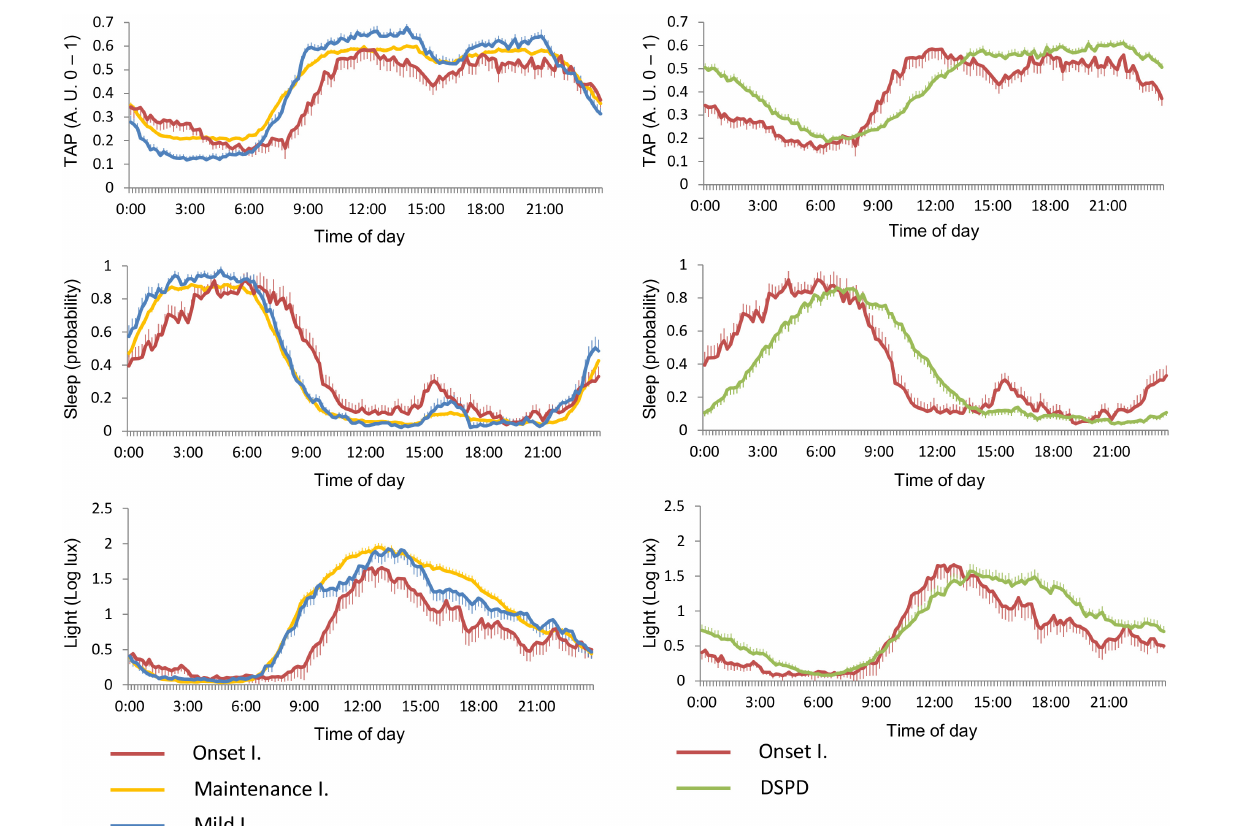
FIGURE 4 | Mean circadian waveforms (from top to bottom) for TAP, estimated sleep, and exposure to environmental light rhythms, for insomnia subtypes (left) and onset insomnia vs. DSPD (right) . Data are expressed as mean ± SEM.